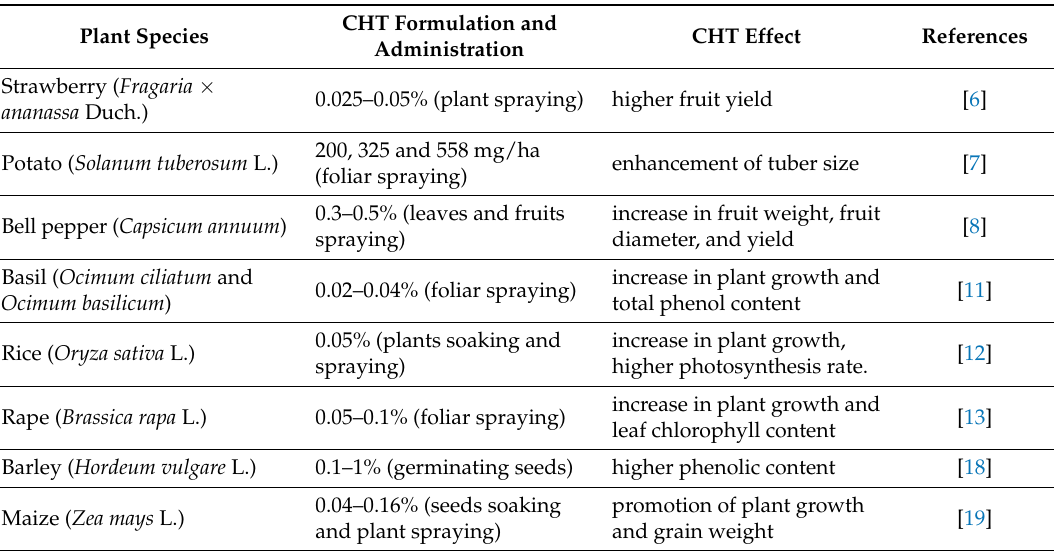
Table 1. CHT effects on plant